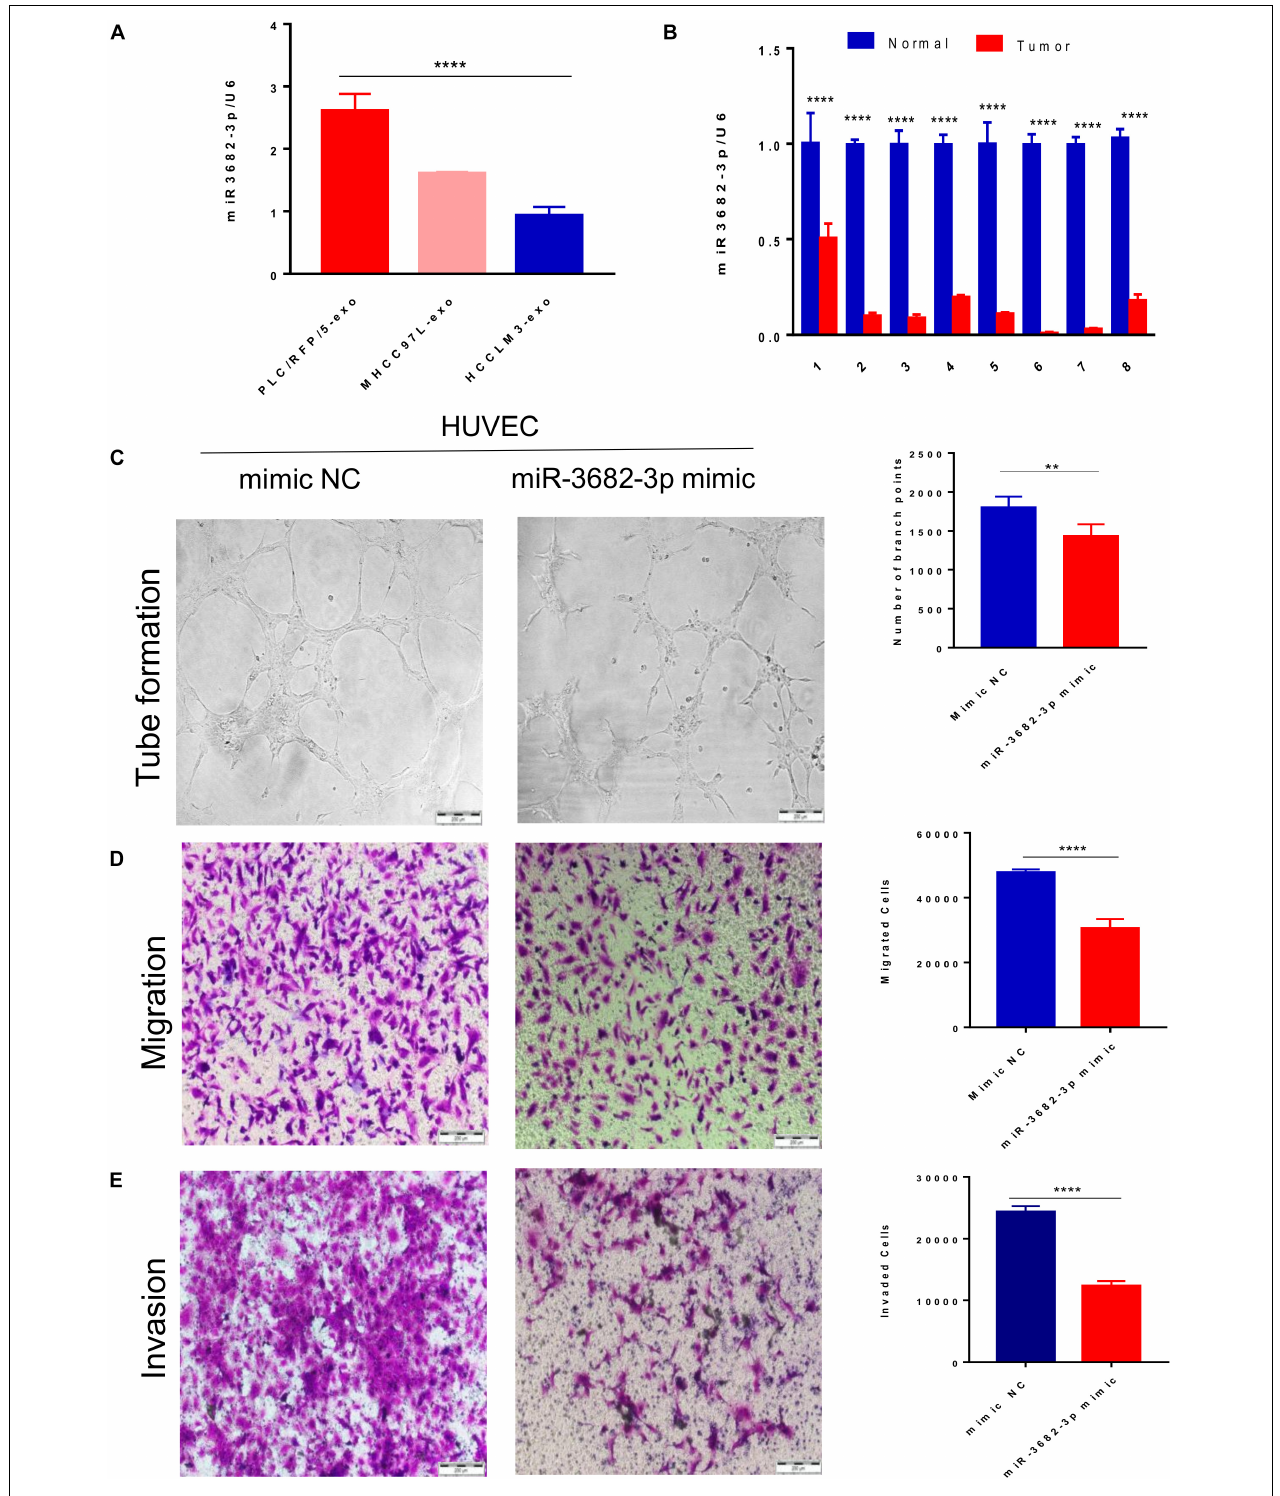
FIGURE 5 | Exosomal miR-3682-3p secreted by liver cancer cells suppressed HUVECs angiogenesis. (A) The microarray results were verified by qPCR. (B) The miR-3682-3p expressions in 8 frozen HCC tissues were generally decreased as compared with their corresponding normal tumor–adjacent tissues. (C–E) Tube formation assays (C) , migration assays (D) , and invasion assays (E) of HUVECs transfected with miR-3682-3p-mimic or negative control. Scale bar, 200 µ m. (* p < 0.05; **i < 0.01; *** p < 0.001; **** p < 0.0001.)